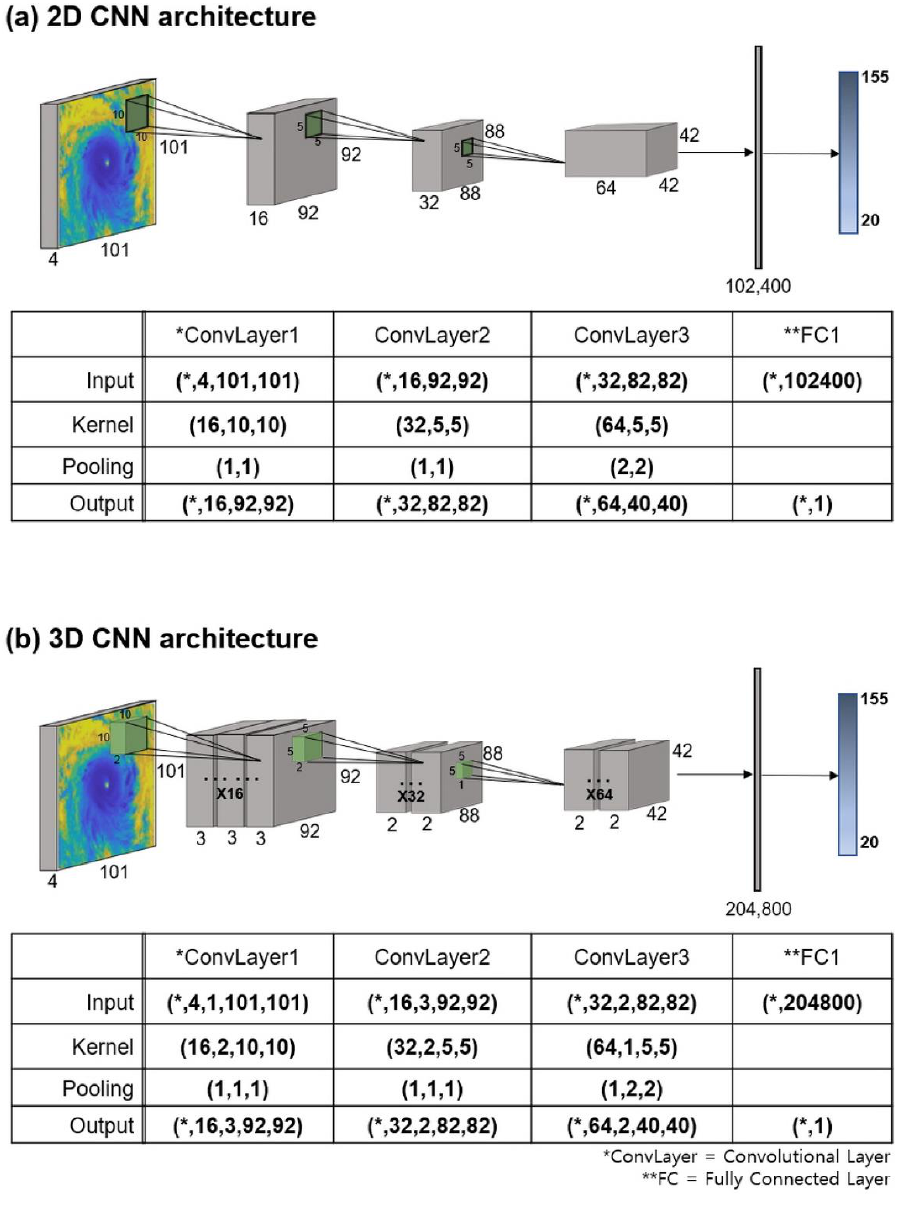
Figure 5. ( a ) 2D-CNN model architecture and ( b ) 3D-CNN model architecture used in this study